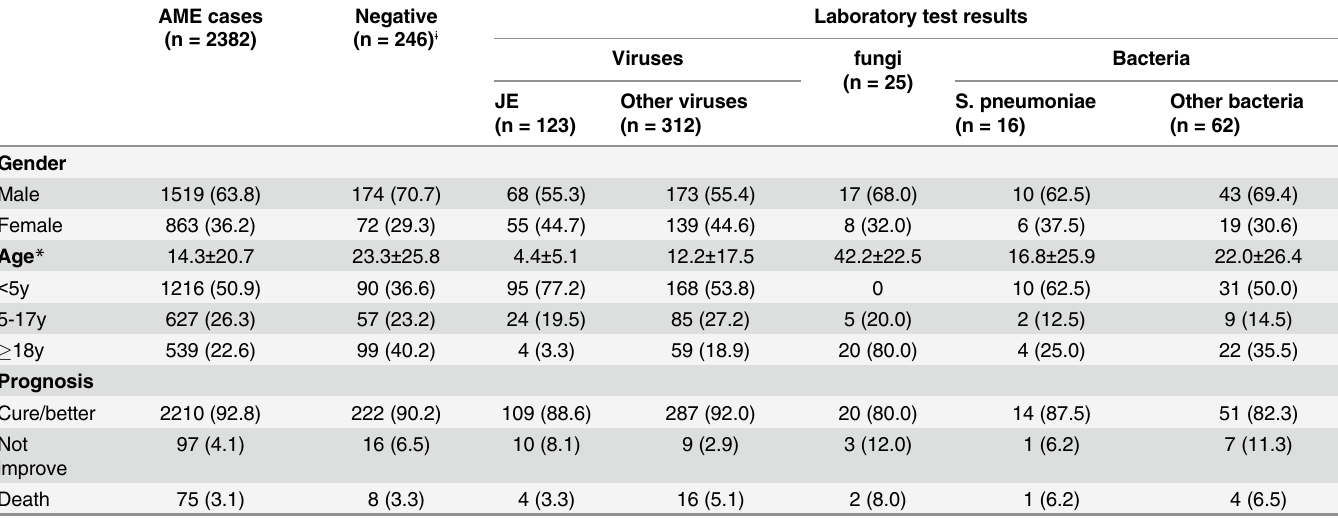
respectively. There were 78 bacterial meningitis cases. Of these, 22 cases were caused by three vaccine-preventable pathogens ( Sp , Nm and Hib ), and 56 cases by 31 other bacteria. The lead- ing etiologic bacteria were Streptococcus sp . (27) and Staphylococcus sp . (18). Of 25 patients infected with fungi, 22 were infected with Cryptococcus neoformans , nineteen of whom were Table 3. General characteristics of acute meningitis and encephalitis (AME) cases, Japanese encephalitis (JE), other viral encephalitis, fungi, and bacterial meningitis in Guigang City, Guangxi, May 2007- June